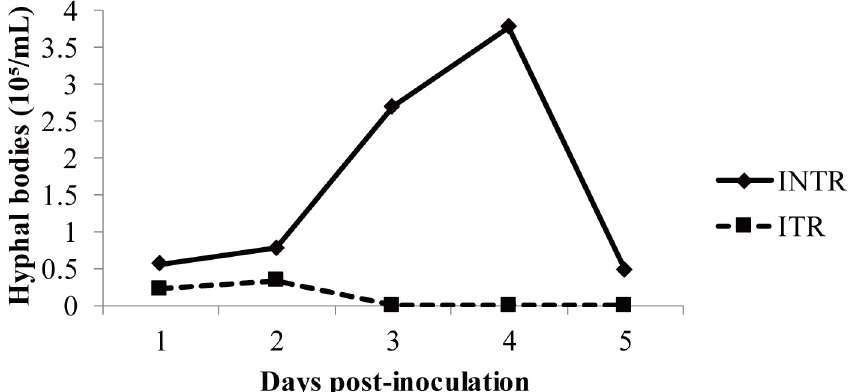
Fig 8. Total blastospore count. Mean blastospore concentrations in haemolymph samples of Locusta migratoria manilensis inoculated with Beauveria bassiana (3 × 10 5 spores/5 th instar nymph), at different numbers of days post- infection. INTR, infected non-thermoregulating insects; ITR, infected thermoregulating insects. Data are given as concentration (means ± SE). 10–15 insects were infected per treatment and per interval.